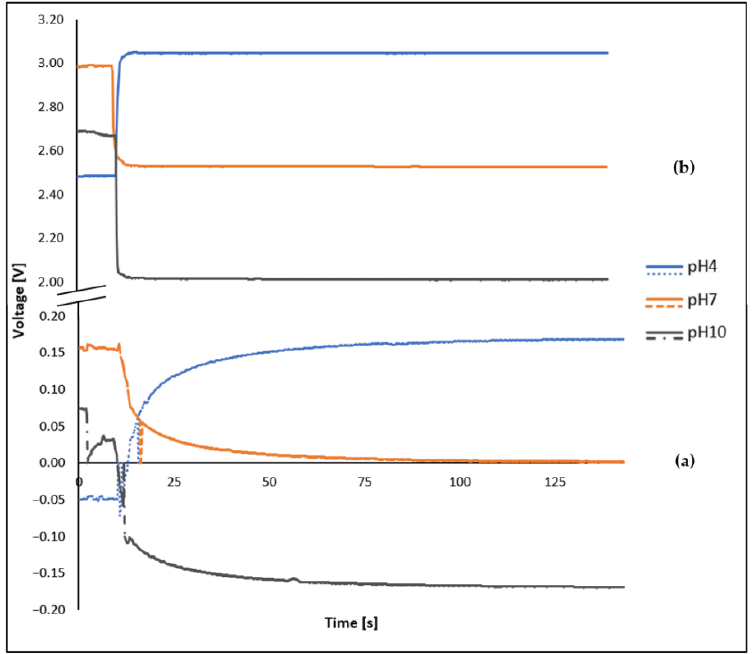
Figure 5. The sensor characterization is performed in two different phases: ( a ) utilizing a multimeter and ( b ) employing the instrumentation described in this proposal. Table 1. Statistical parameters derived from pH sensor characterizations: Phase I and Phase II.